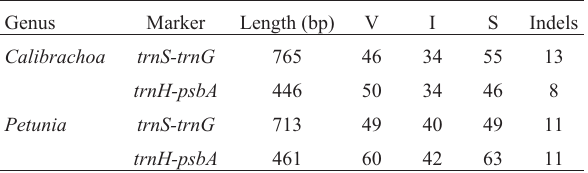
Table 1 - Molecular variability of plastid